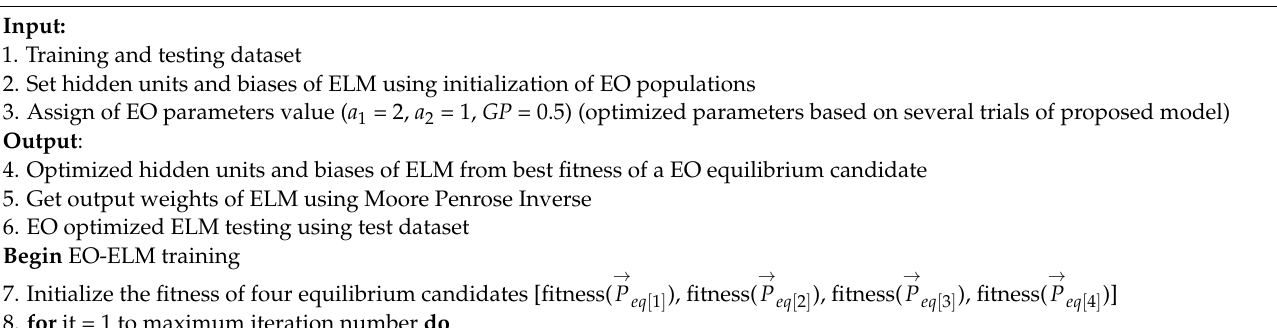
Algorithm 2 : The algorithm of